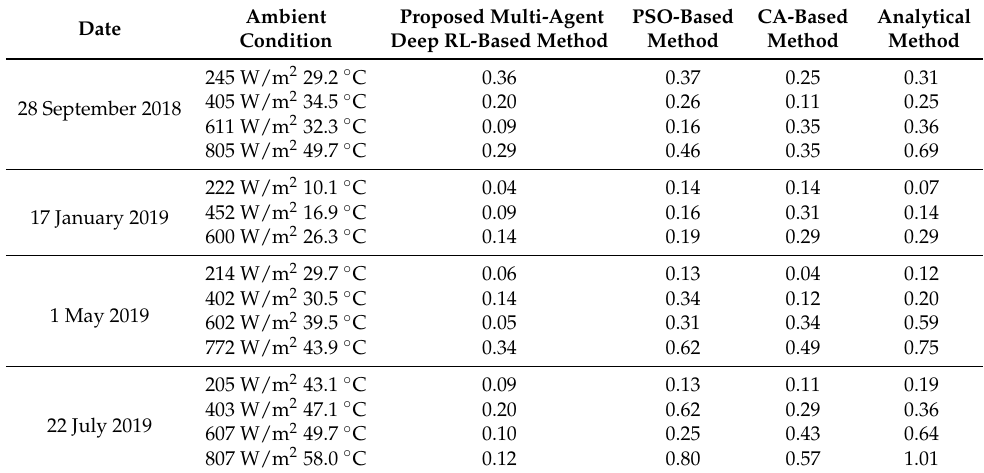
Figure 7. Comparison of measured and model estimated I–V characteristics in typical days in four seasons: ( a ) 28 September 2018, autumn; ( b ) 17 January 2019, winter; ( c ) 1 May 2019, spring; and ( d ) 22 July 2019, summer. Table 4. Comparison of MAE (A) for different methods in Figure 8. Ambient Proposed Multi-Agent PSO-Based